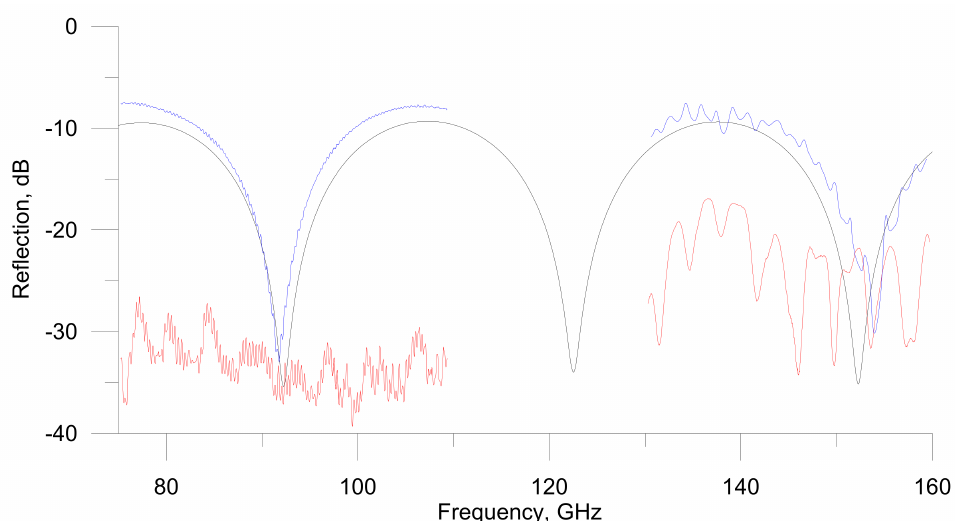
Figure 5. Reflection from the 3D-printed disk with a flat surface on both sides. The black line corresponds to the numerical simulation in CST Studio. The blue line is the measured reflection coefficient, and the red line is the lower sensitivity limit of the measurement setup.